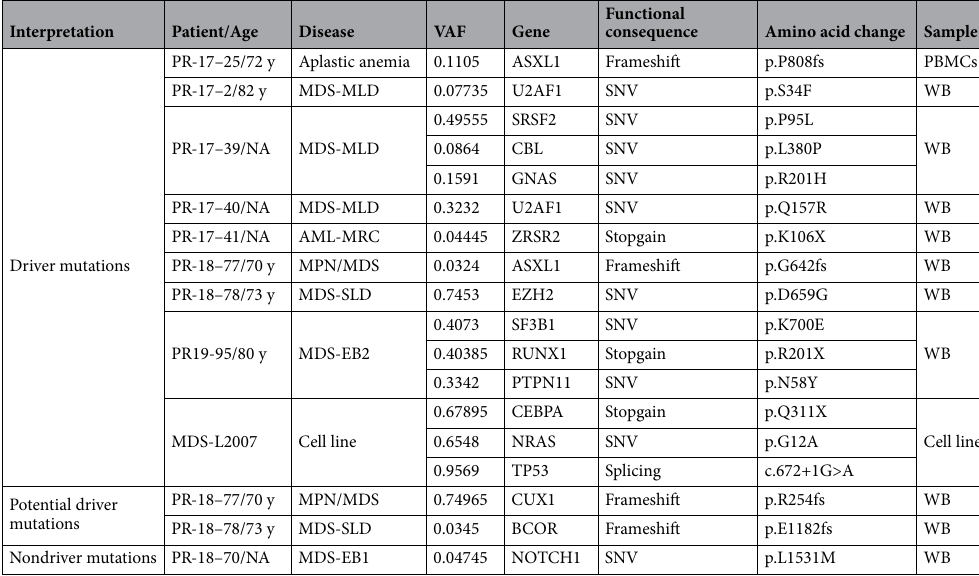
Table 2. Driver and nondriver mutations in aplastic anemia and myeloid neoplasms. MDS myelodysplastic syndrome, MDS-MLD MDS with multilineage dysplasia, AML-MRC acute myeloid leukemia with myelodysplasia-related changes, MPN , myeloproliferative neoplasm, MDS-SLD MDS with single lineage dysplasia, MDS-EB MDS with excess blasts, NA not available, PBMCs peripheral blood mononuclear cells, WB whole